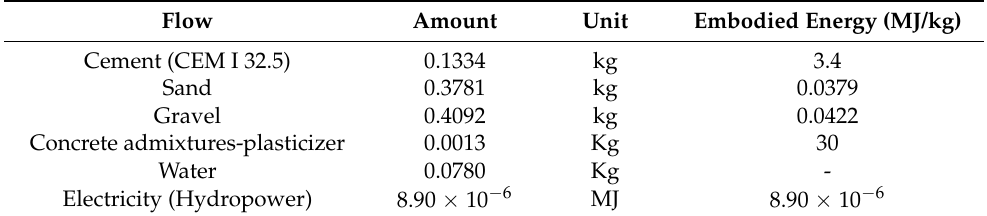
Table 2. Inventory data and embodied energy for 1 kg concrete production in Iceland—source: [42].